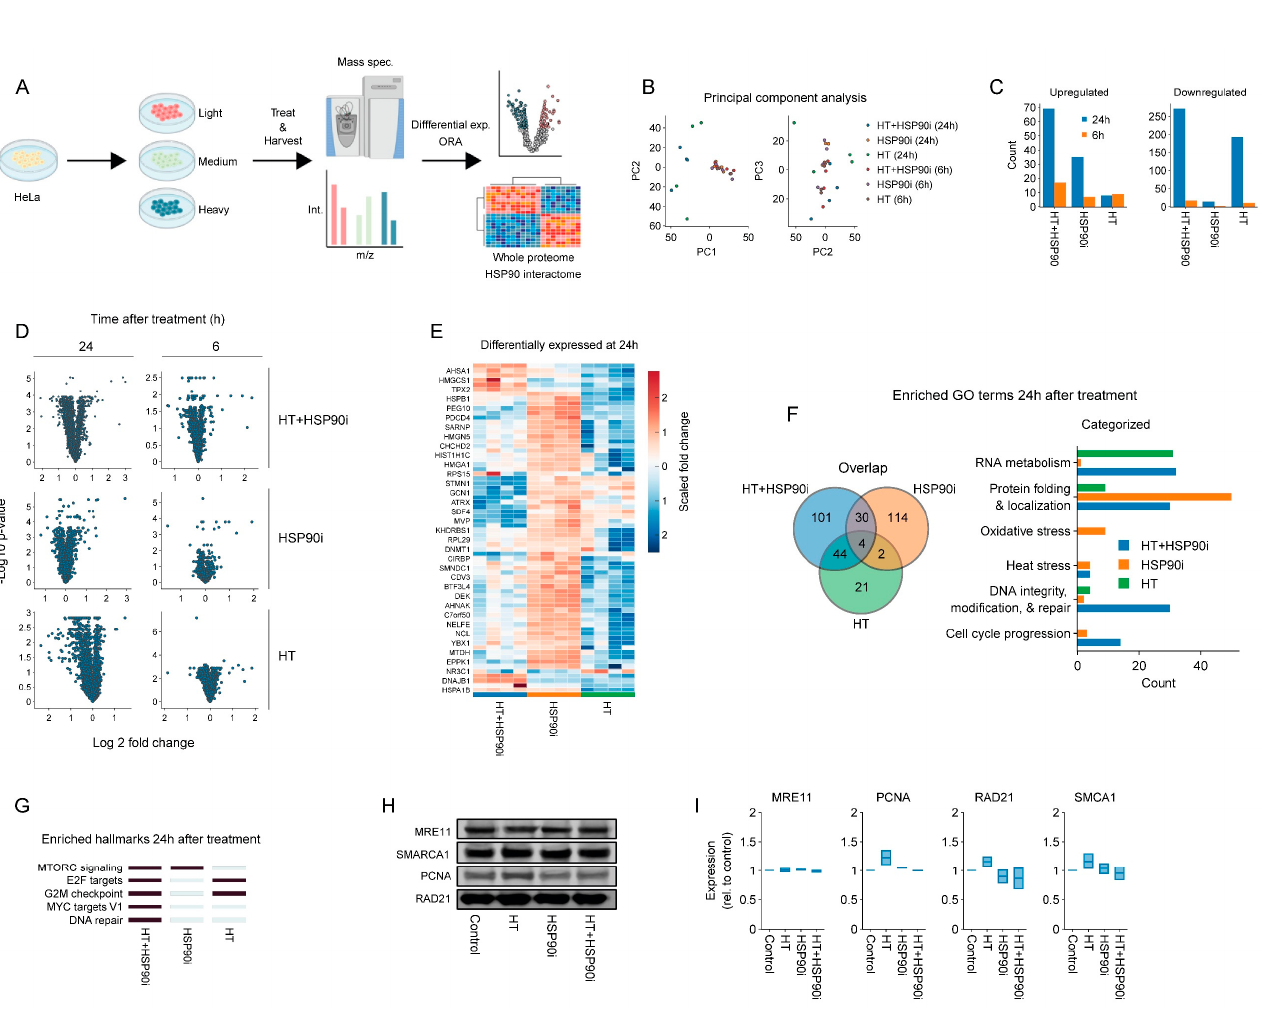
Figure 4. Proteome alterations caused by ganetespib and hyperthermia. ( A ) Experimental setup. The HeLa cells were labeled in SILAC media, exposed to combinations of 30 nM of ganetespib (HSP90i) and hyperthermia (HT), and processed for proteomics and downstream analysis. ( B ) Principal component analysis. ( C ) Number of up- and downregulated proteins (log2 fold change higher than 0.5 or lower than − 0.5). ( D ) Volcano plots of all conditions. ( E ) Heatmap of proteins found to be up- or downregulated under at least one condition. Overrepresentation analysis on up- and downregulated proteins yielded results presented in panels ( F , G ). ( F ) Venn diagram and hand-curated categories of gene ontology (GO) terms found to be enriched per condition. ( G ) Heatmap displaying enriched hallmark gene sets (marked in dark blue). ( H , I ) Immuno-blots and quantifications showing the expression of proteins of interest 24 h after HT. Equal protein loading was ensured by a Lowry assay. The uncropped blots are shown in Figure S4.